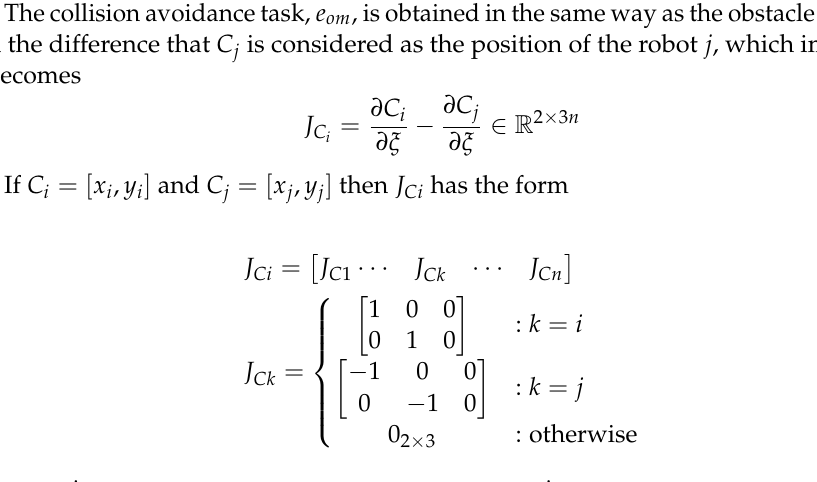
Figure 7. Collision avoidance